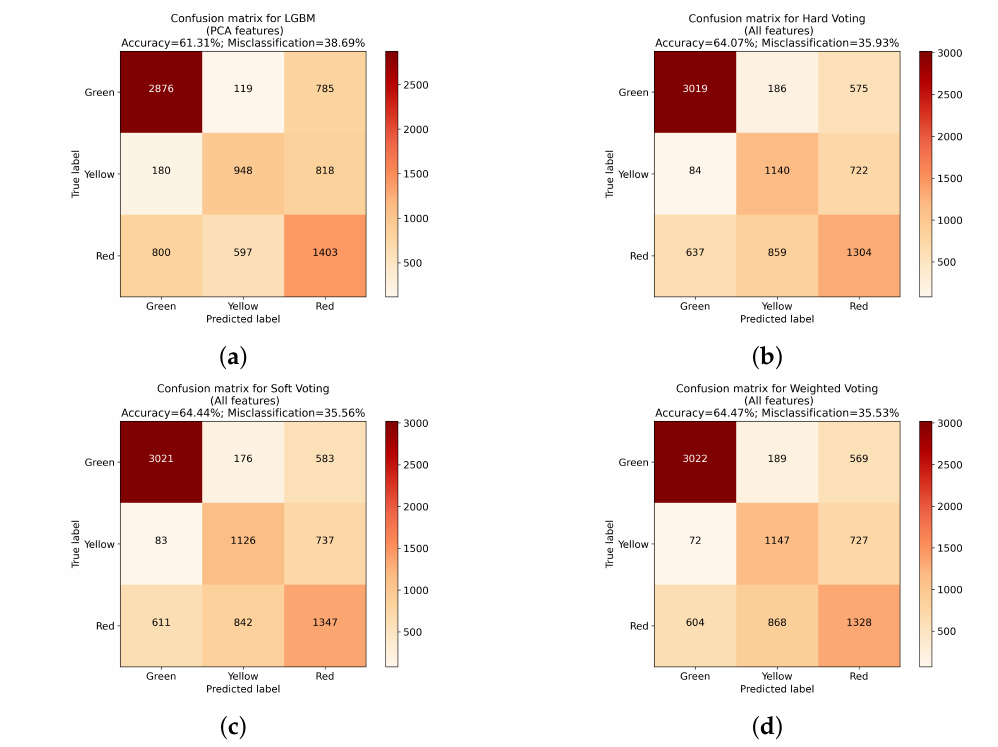
Figure 6. Confusion matrices for the best classifier trained using each feature set for PCA-based and voting-based approaches. ( a ) LGBM using PCA on all features. ( b ) Hard voting classifier on all